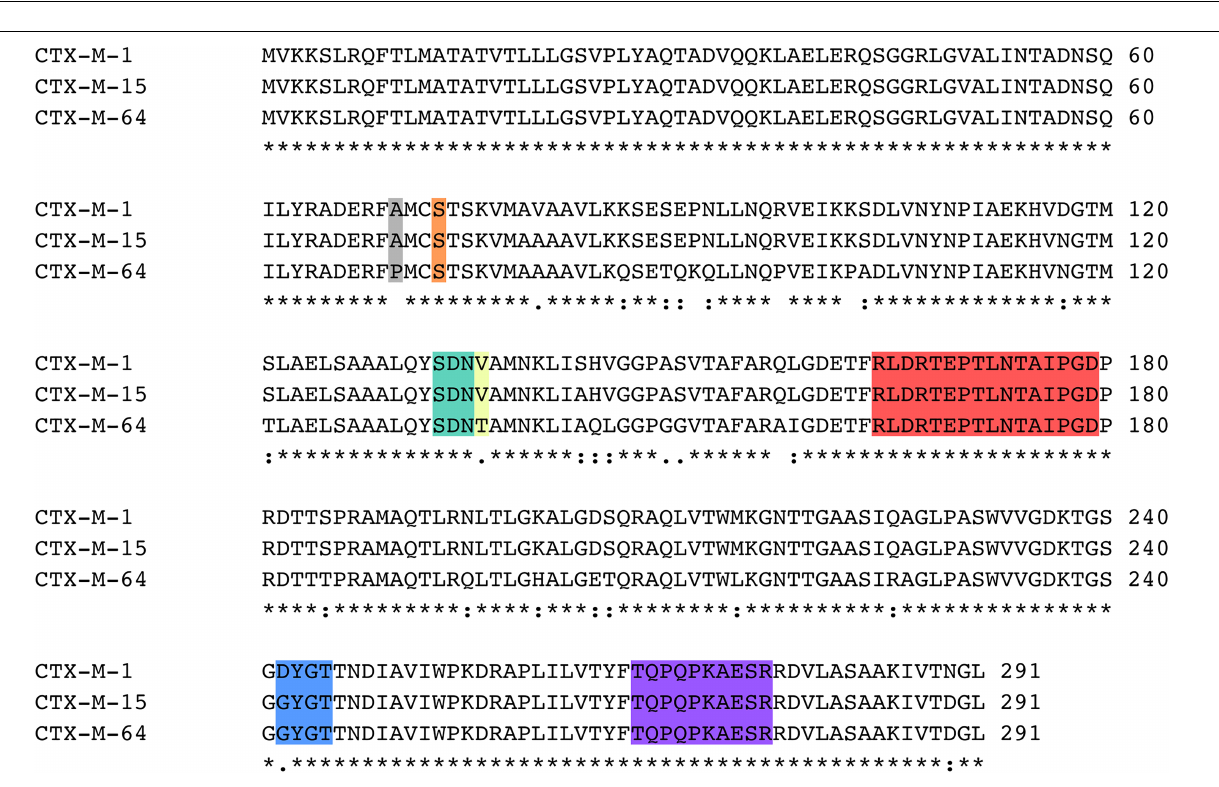
FIGURE 2 | Structural alignment of CTX-M-1-sub family apo structures. (A) Alignment of CTX-M-15 (green, 4HBT) CTX-M-64 (blue, 5ZB7), and CTX-M-96 (pink, 3ZNY). Global β -lactamase fold architecture is conserved. (B) Comparison of CTX-M-15 and CTX-M-64 A67P and V133T mutations. These two mutations are the closest to the active site. Other mutations are mainly located in the α -helical bundle.